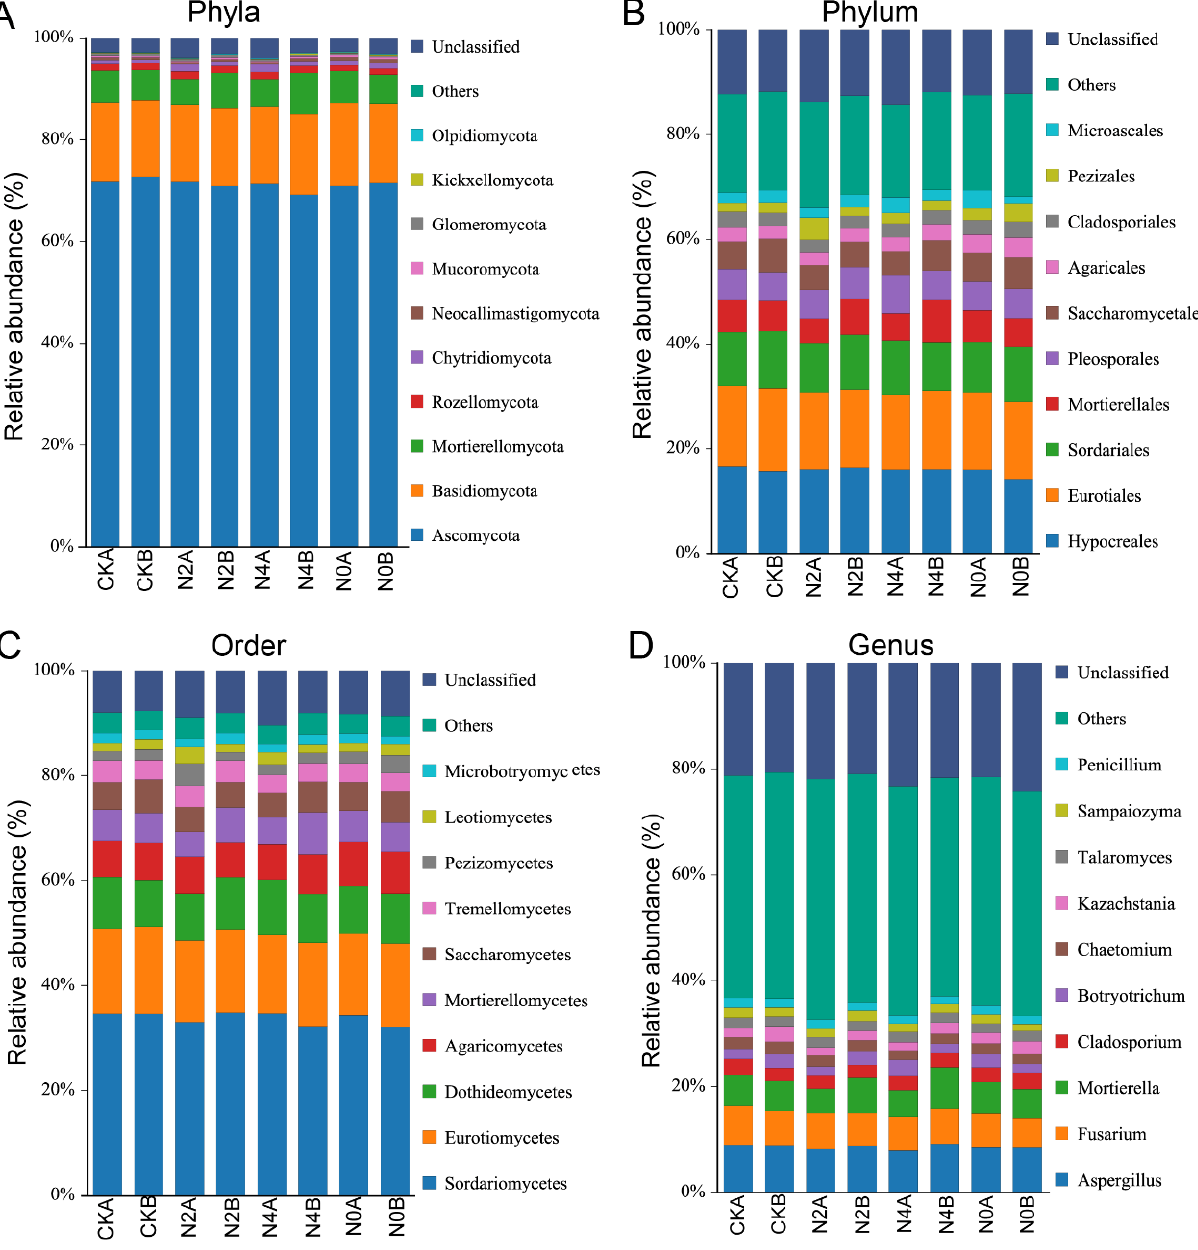
Figure 8. Relative abundance of dominant fungi at different taxonomic levels. The horizontal axis represents different samples. The vertical axis represents the relative abundance. ( A ) Phyla level. ( B ) Phylum level. ( C ) Order level. ( D ) Genus level.